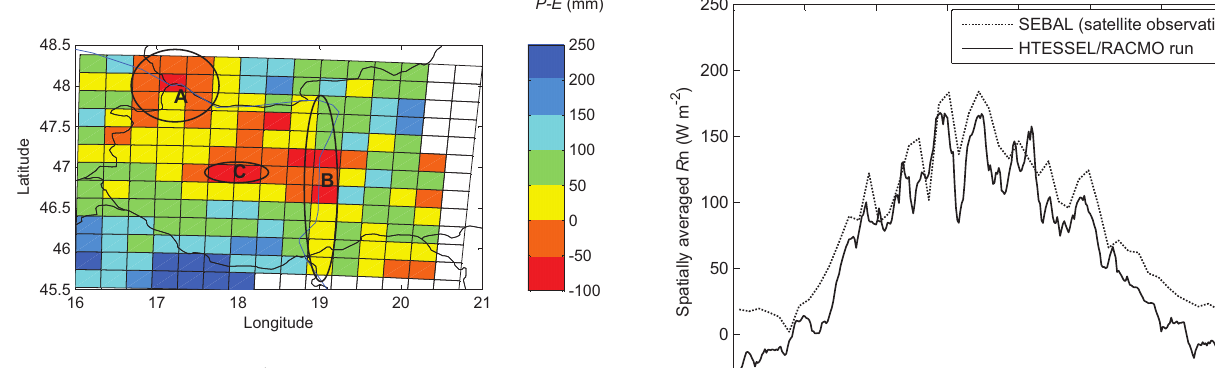
Fig. 7. Potential recharge (Annual P TRMM – Seasonal E SEBAL ) over 2005 in the Transdanubian region. The areas A and B represent irrigated cropland area and C represents lake Balaton. The spatial resolution is 0.25 ◦ . The SEBAL evaporation is averaged over 30 weeks starting in week 13. Fig. 8. Weekly averaged, daily net radiation R